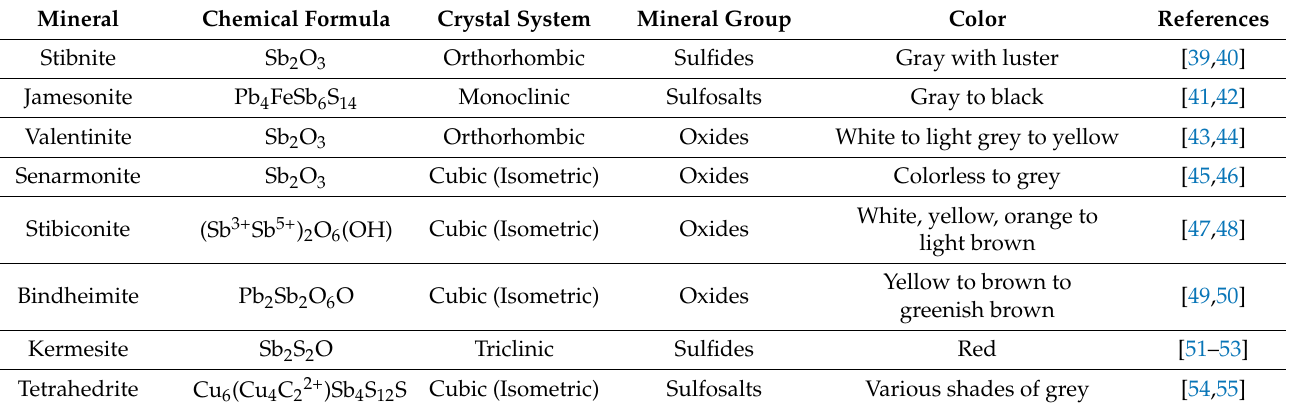
Table 2. Economically important antimony